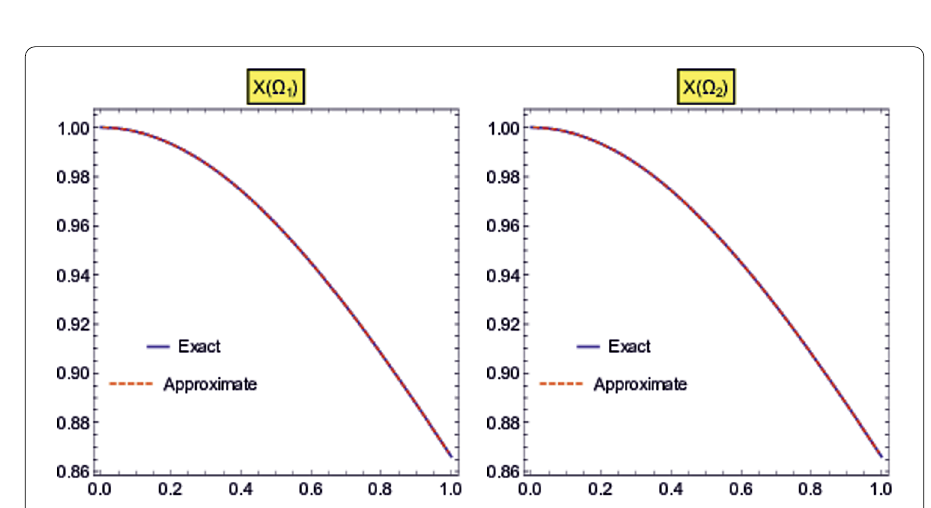
Figure 6 Comparison of the exact and approximate solutions of Example 4.2 for m = 3